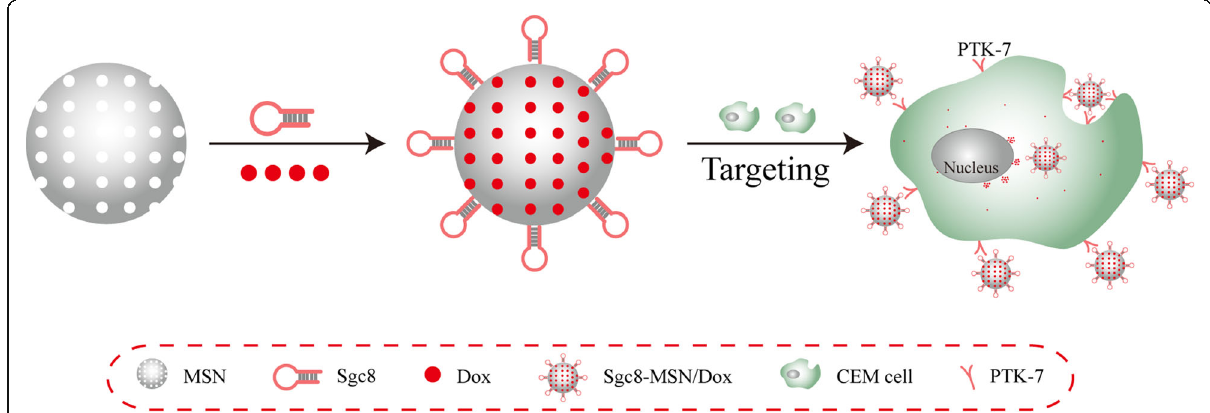
Fig. 1 Schematic illustration of Sgc8 aptamer-modified mesoporous silica nanoparticles for an efficient cell-targeting drug delivery system. CEM cell, CCRF-CEM human acute T lymphocyte leukemia cells; Dox, doxorubicin; MSN, modified silica nanoparticle; PTK-7, protein tyrosine